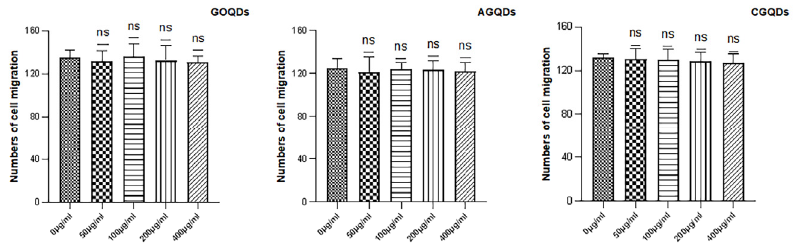
Figure 10. The statistics of the Transwell cell migration map of HSFs labeled with GOQDs, AGQDs and CGQDs, respectively.